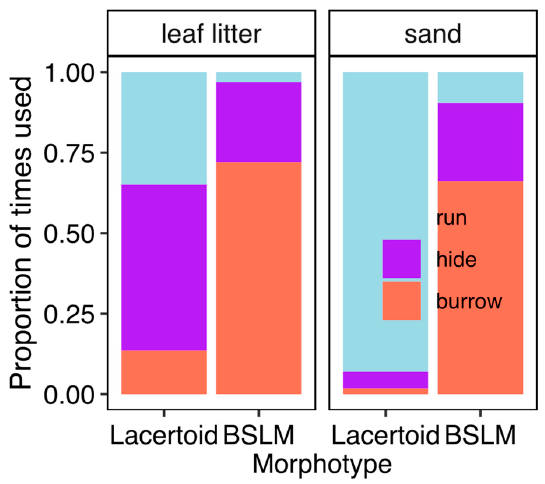
Figure 2. Variation in the use of escape strategy used by ten species of lizards of two morphotypes that were made escape over bare sand layer and sand covered by a thin leaf litter layer. Table 1. Morphotype interacts with substrate type, driving the flight strategy of lacertoid and snake- like lizards. Estimates represent changes in the odds of choosing to burrow or hide with respect to choose running as flight strategy. Burrowing snake-like morphotype (BSLM) exhibit greater odds of burrowing during escape, either on clean sand or in sand covered with leaf litter cover. In turn, clean sand decreases the odds of burrowing or hiding because lacertoids mostly chose those strate- gies in presence of leaf litter. B = Burrow, H = Hide. Estimate